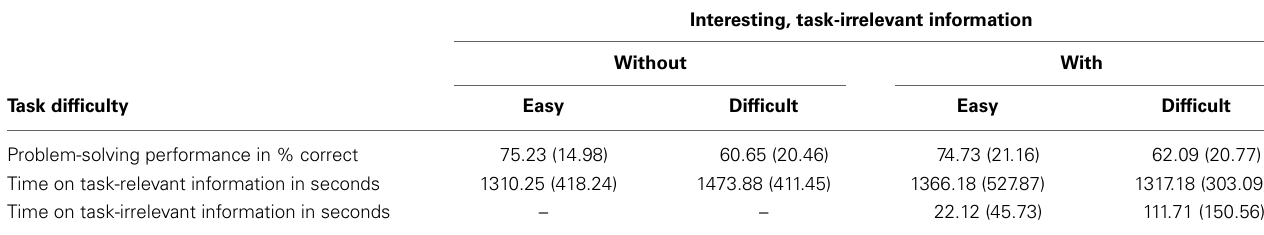
Table 4 | Means (and standard deviations) as a function of interesting, task-irrelevant information and task difficulty (Experiment